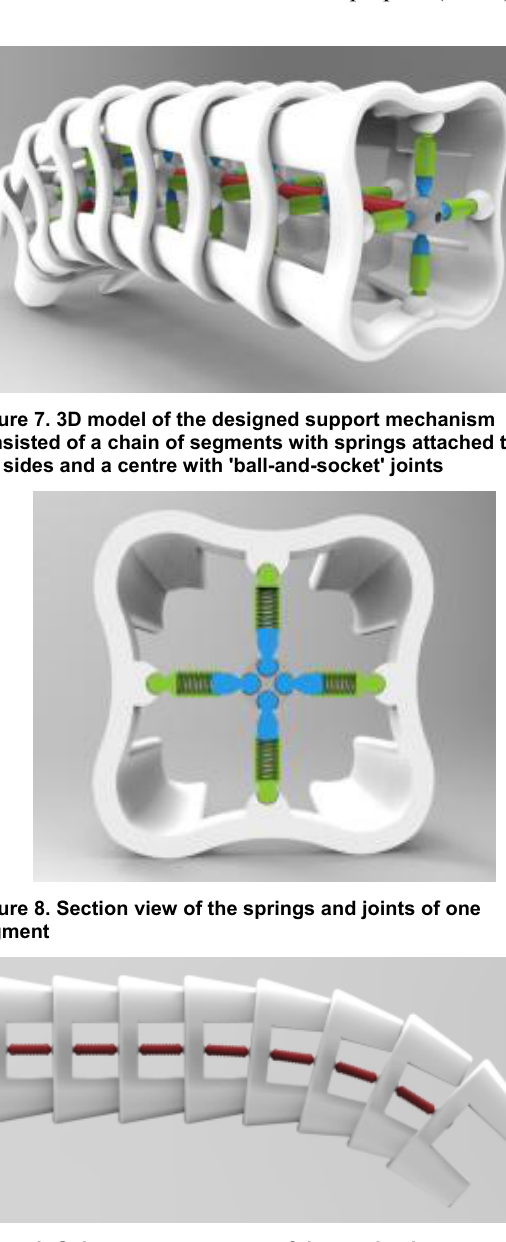
Figure 9. Subsequent segments of the mechanism connected by